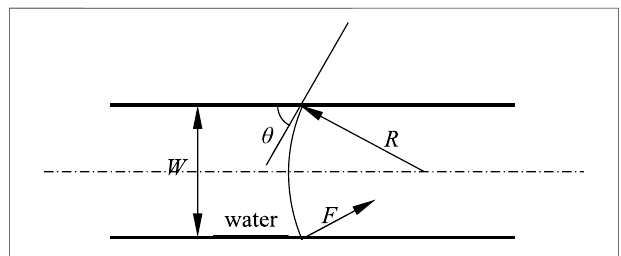
FIGURE 9 | Force analysis of capillary